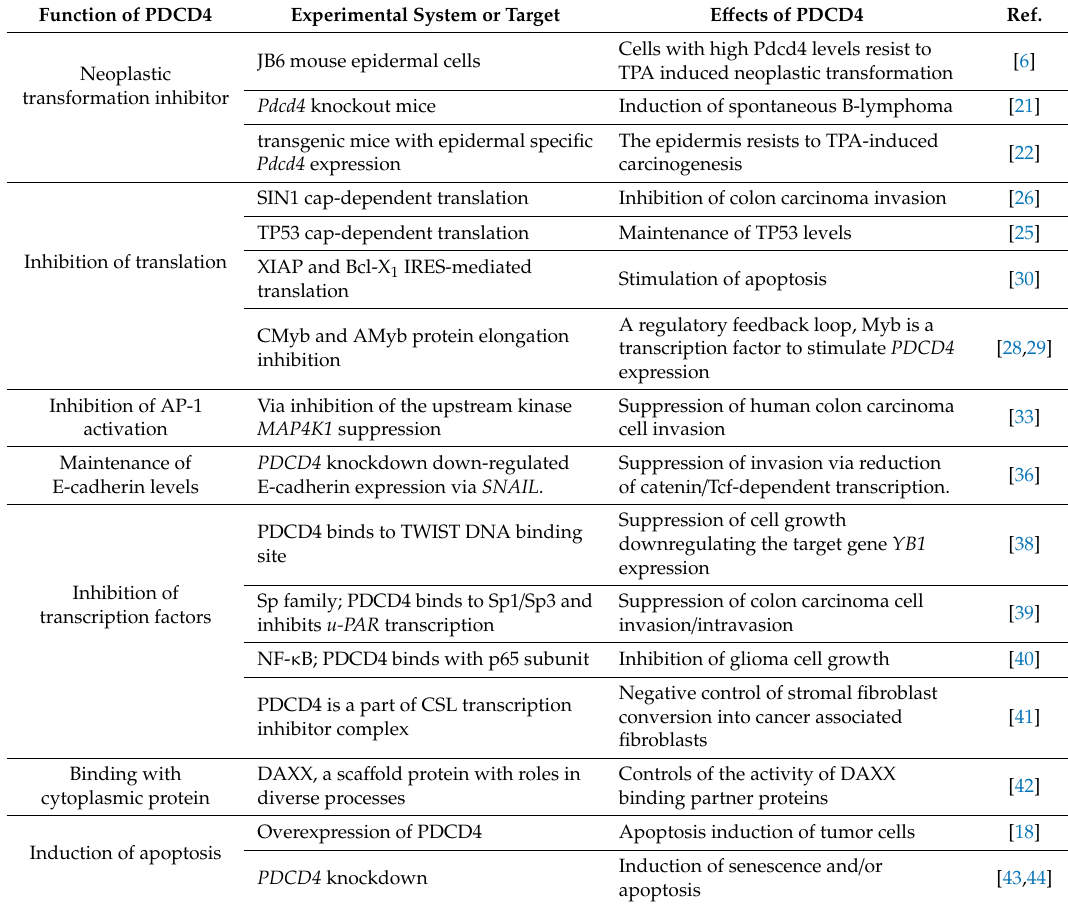
Table 1. Molecular Functions of